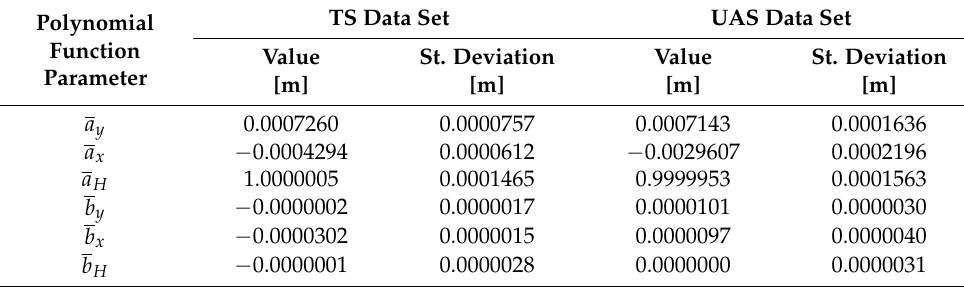
Table 9. The 2nd degree polynomial function (quadratic curve) parameters of both the reference TS-based data set and of the validation UAS-based data